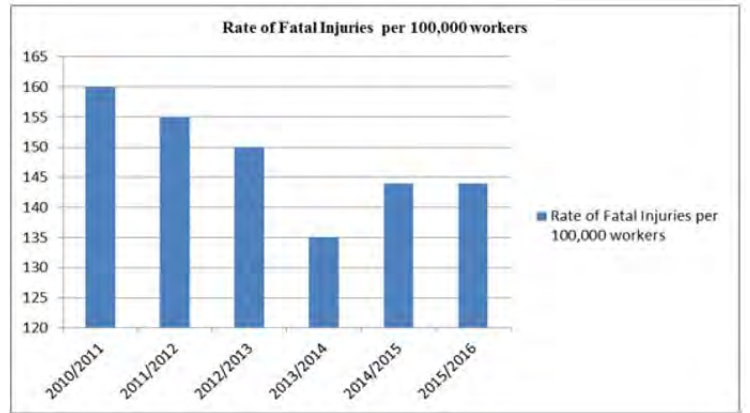
Figure 1. Rate of fatal work-related injuries per 100,000 workers as estimated by Health and Safety Executive (HSE) As indicated by Health and Safety Executive, the statistics in figure 1 demonstrate the quantity of laborers fatally harmed in 2015/16 is 144, and relates to a rate of deadly damage of 0.46 deaths for every 100,000 labourers. Over the most recent 20-year era there has been a descending pattern in the rate of fatal injury (Workplace fatal injuries in Great Britain 2018,